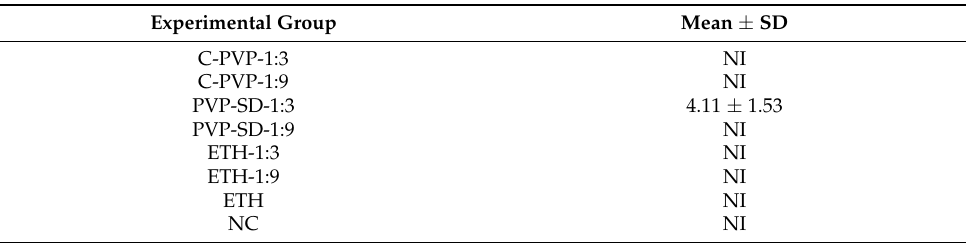
Table 9. Mean of the values (mm) of the inhibition zone of the samples (One-way ANOVA with Tukey’s post-test, p <